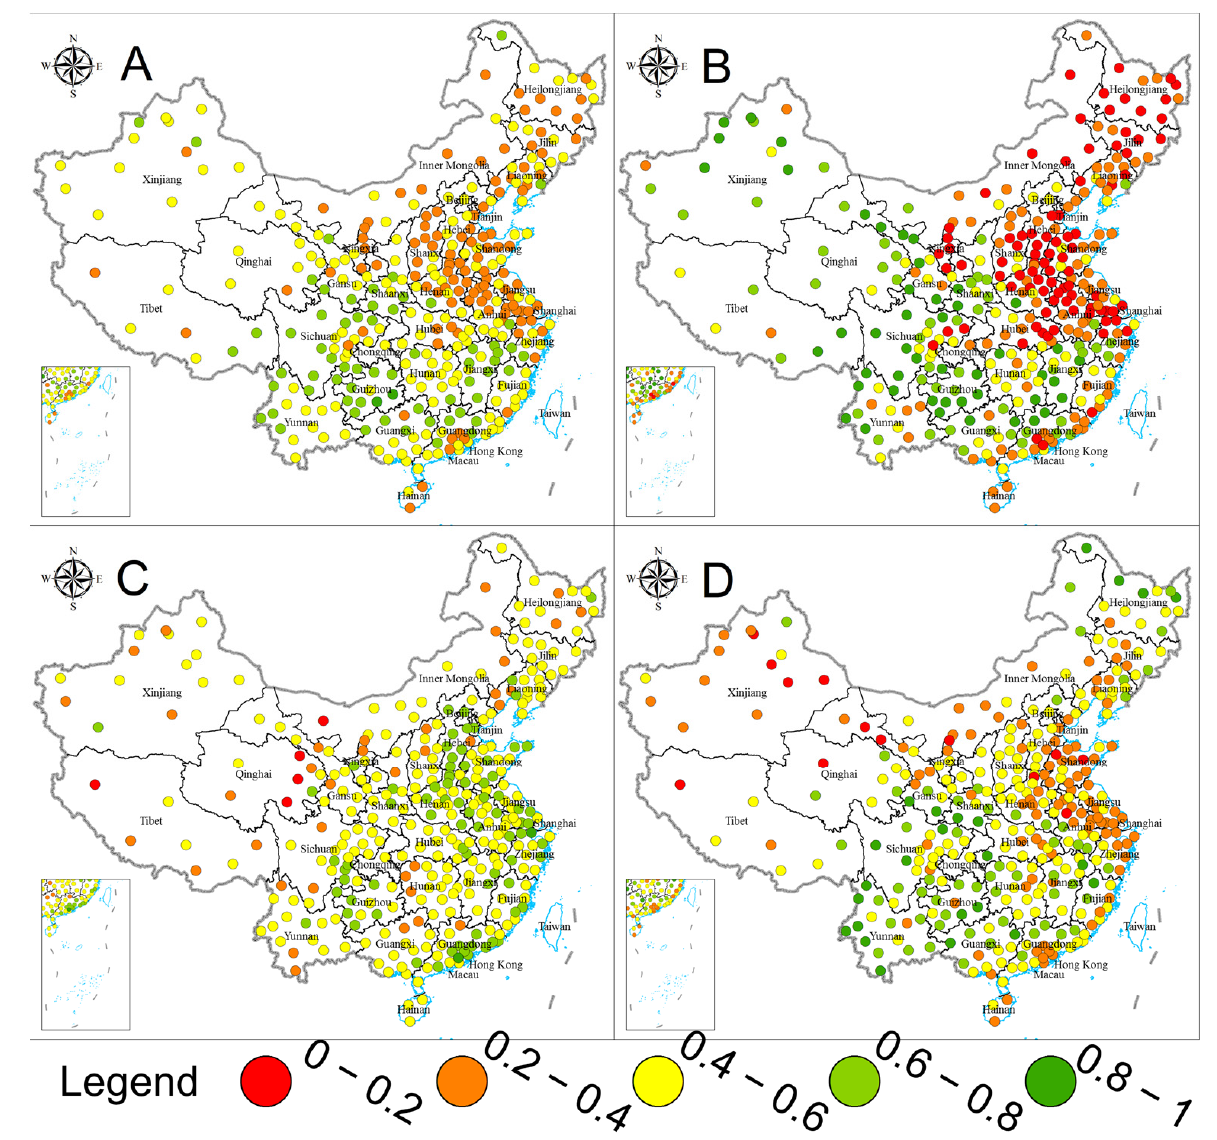
Figure 4. Water sustainability by city ( A ) for water sustainability, ( B ) for water quality, ( C ) for water infrastructure, and ( D for water conservation and rational utilization). Table 3. Spearman’s rank correlation fitting